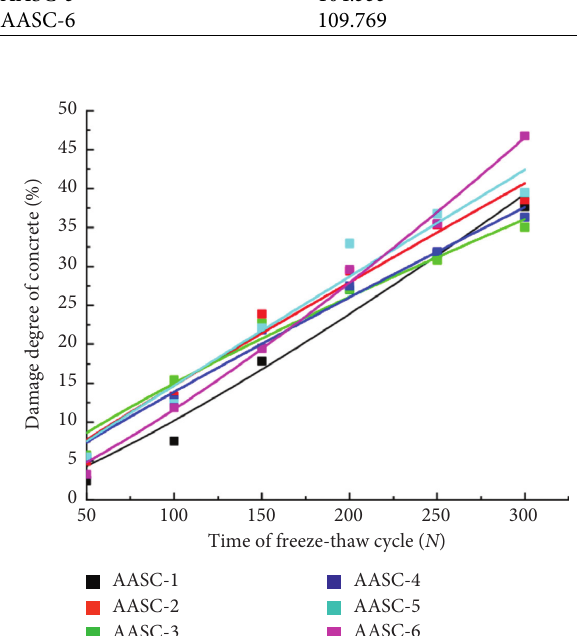
Figure 13: Compressive strength accumulative damage power function model.